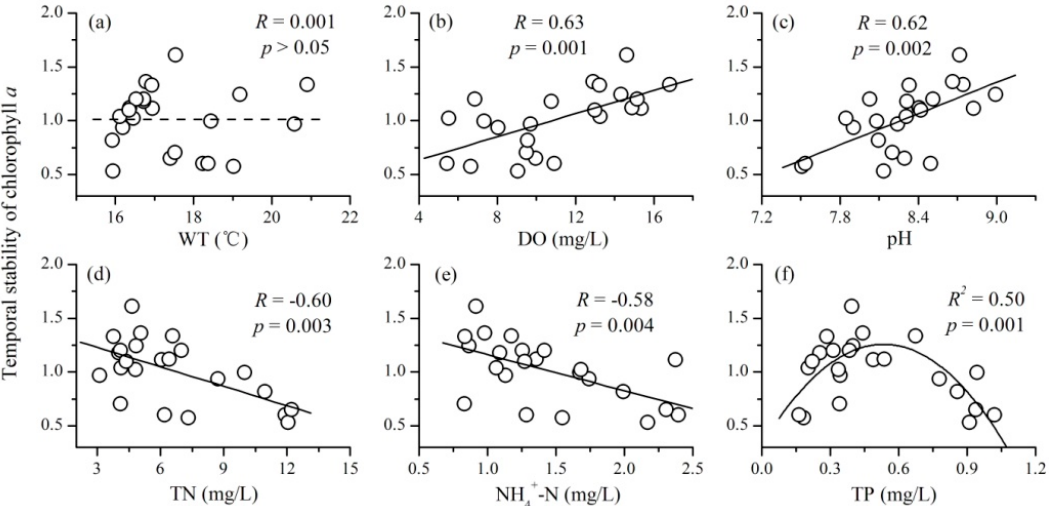
Figure 5. The relationships between the mean values of ( a ) water temperature (WT); ( b ) dissolved oxygen (DO); ( c ) pH; ( d ) total nitrogen (TN); ( e ) ammonia nitrogen (NH 4+ ‐ N); ( f ) total phosphorus (TP) and the temporal stability of phytoplankton biomass (chlorophyll a ) in Lake Qixinghu. The fitting of regression equations is calculated using the 23 sample sites in the lake (all N = 23).